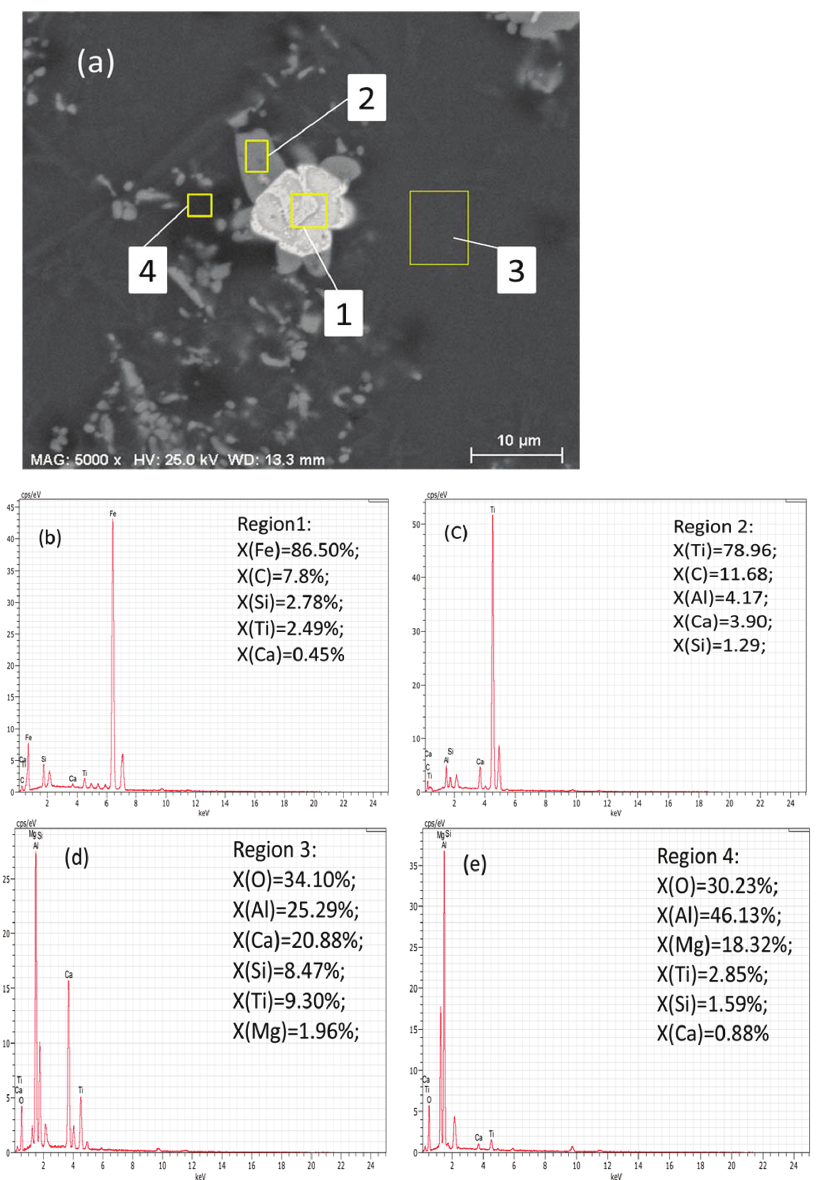
Figure 17: SEM image (a) of reduced sample at 1,673 K (with carbon ratio 0.85, 2 h) and EDS results of regions 1 (b), 2 (c), 3 (d) and 4